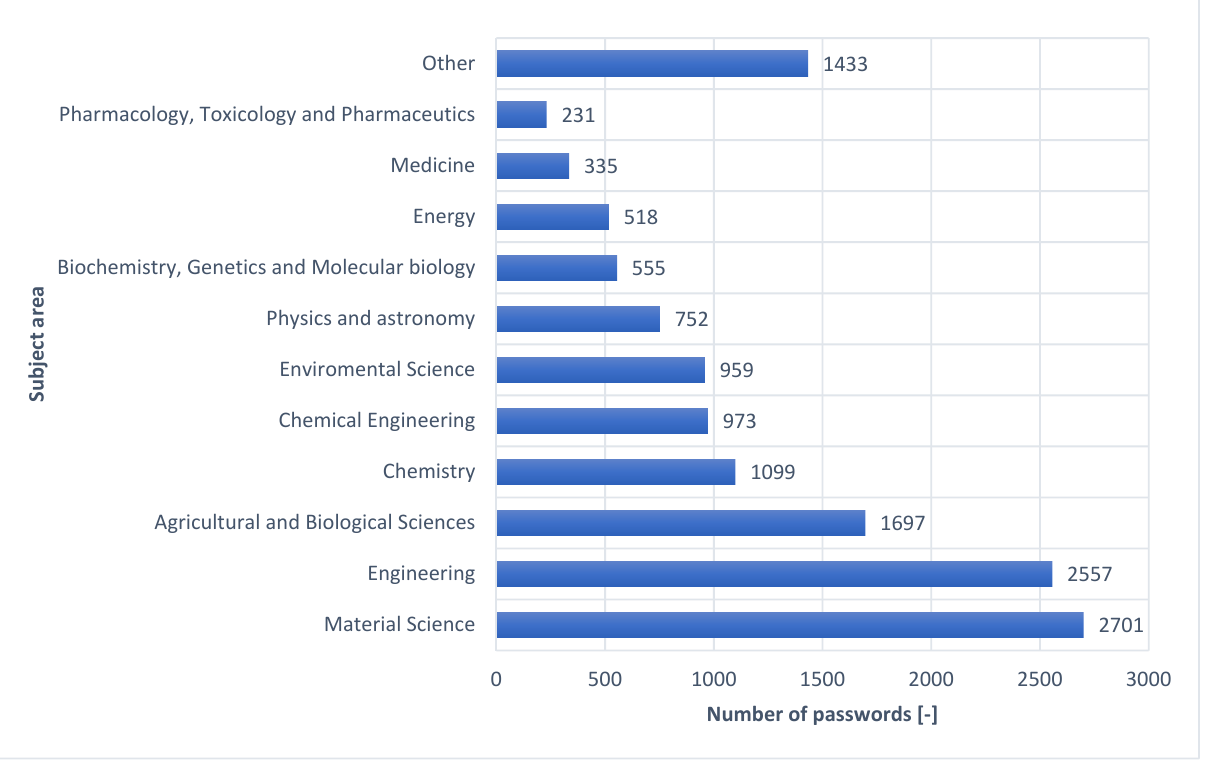
Figure 5. The number of occurrences of the phrase “hemp” in the Scopus database in the last 10 years, broken down into individual fields (as of 5 December 2021).